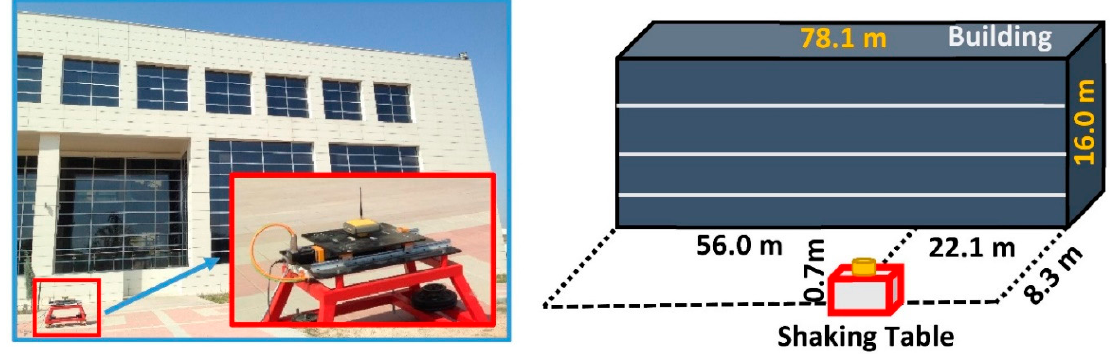
Figure 3. Location of the shaking table with respect to the building.